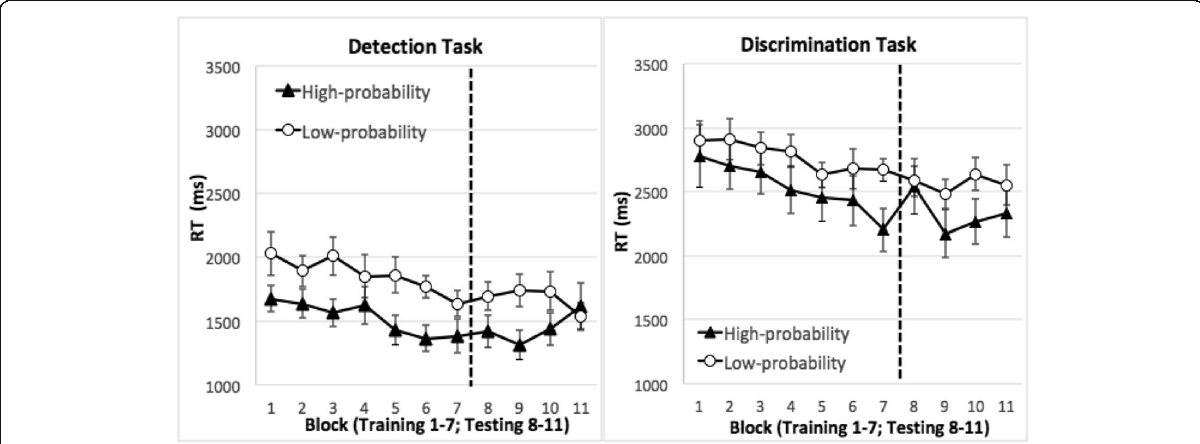
Fig. 2 Target-present RT data from Experiment 1. The first seven blocks were the training phase (the target appeared in the high-probability quadrant disproportionately often). The last four blocks were the testing phase (the target appeared in all quadrants equally often). Error bars show ±1 S.E. of the